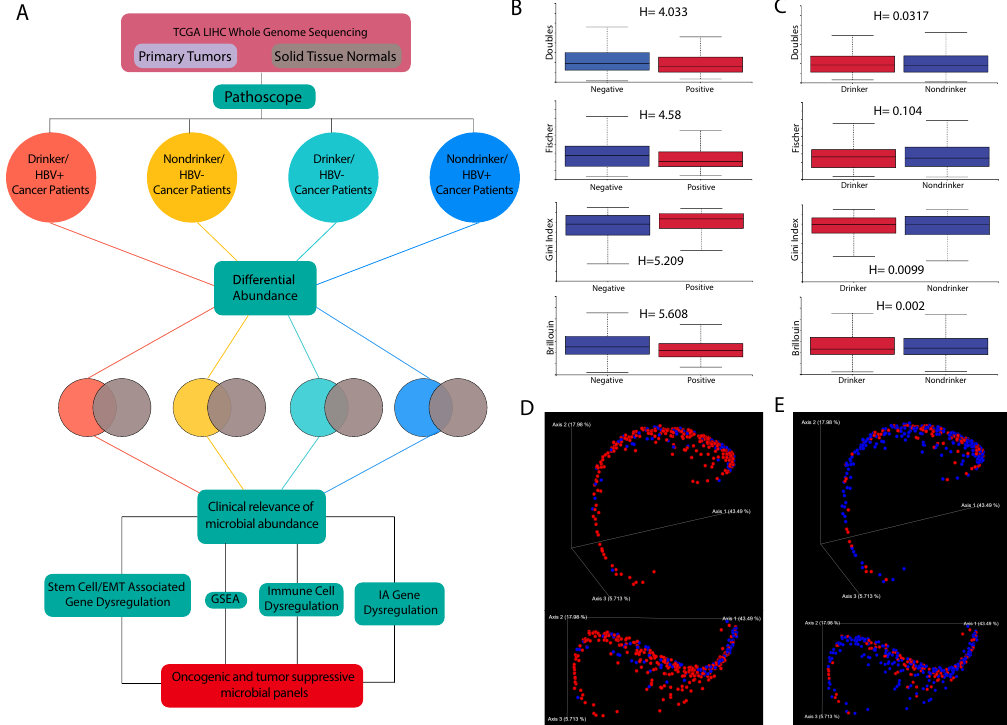
Figure 1. Overview of methods and patient data. ( A ) Schematic overview of the project methods. Comparisons of di ff erent alpha diversity measures (Doubles, Gini Index, Fischer, and Brillouin) between ( B ) hepatitis B HBV + and HBV − patients and ( C ) drinker and nondrinker patients, with significant di ff erences indicated by H-statistics > 1. Principle Component analysis plots of beta diversity per patient with ( D ) red representing HBV + and blue representing HBV − and ( E ) red representing drinker and blue representing nondrinker